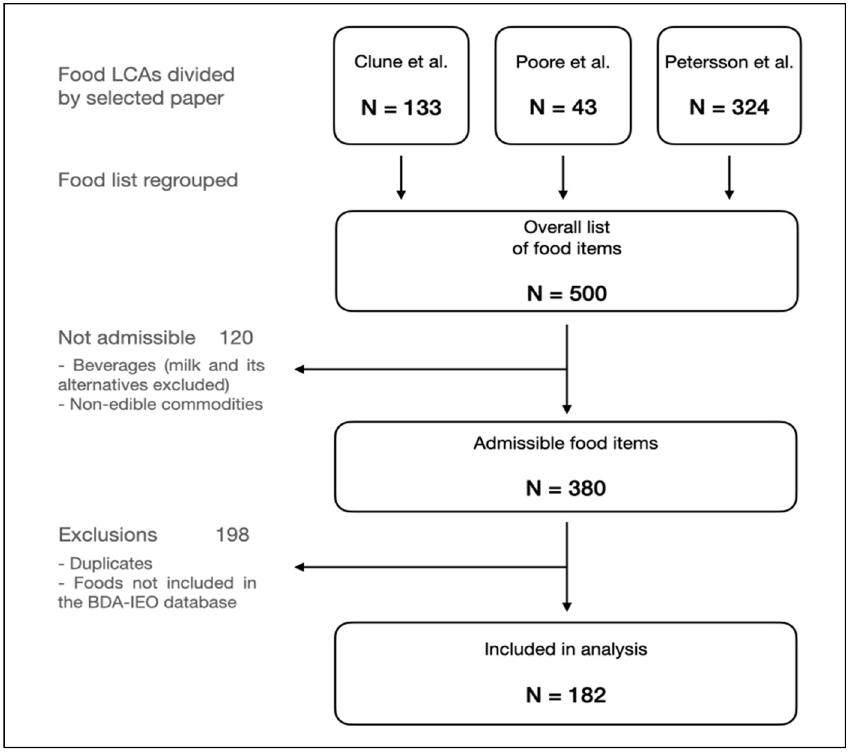
Figure 1. Flow chart of the food product selection. Abbreviations: LCAs = life cycle assessments.